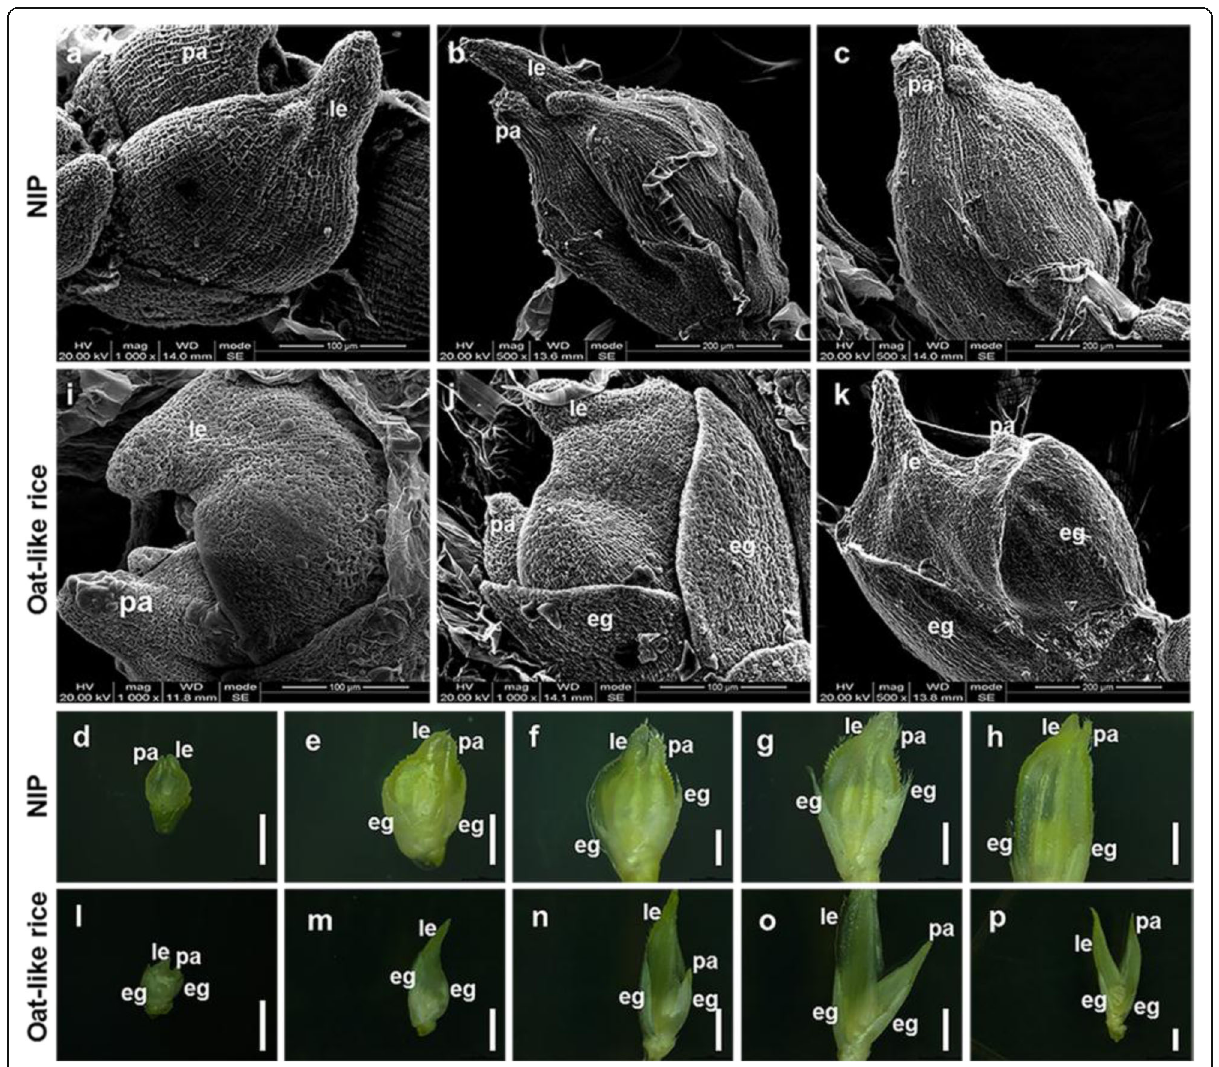
Fig. 4 Observation and analysis of the representatively developmental stages of spikelets by SEM and dissecting microscope . a and i Spikelets of NIP ( a ) and Oat-like rice ( i ) at the stage of Sp8. b-h Spikelets of NIP; j - p Spikelets of Oat-like rice; b-h , j-p Spikelets after stage of Sp8. eg, empty glume; le, lemma; pa, palea; Bars: ( a, i and j )100 μ m, ( b, c and k ) 200 μ m, ( d-h , l - p ) 1